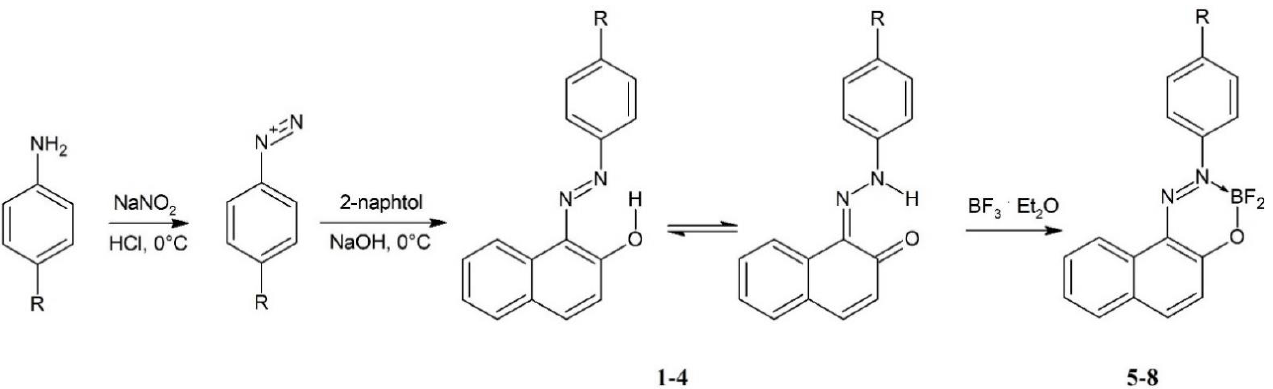
Scheme 3. The schematic representation of the synthesis of difluoroboranes substituted 1-phenylazonaphthalen-2-ols. ( 1–8 ), where R = NMe 2 ( 1 , 5 ), OEt ( 2 , 6 ), i Pr ( 3 , 7 ), H ( 4 , 8